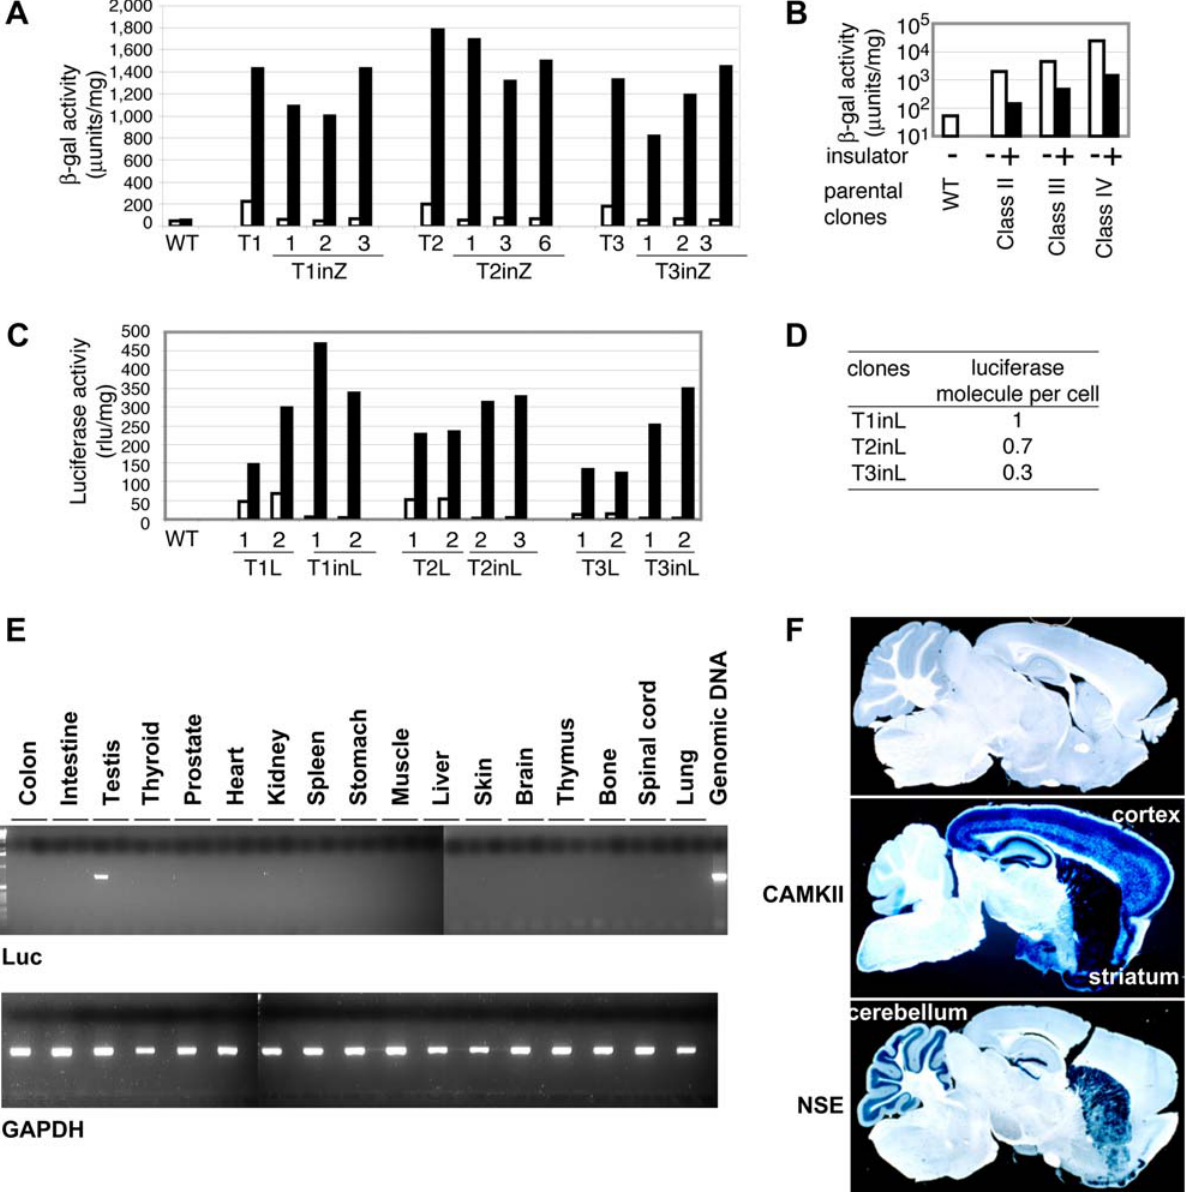
Figure 4. Tightening of gene regulation at TIGRE loci by insulators. (A) Insulator effect in class I clones. Parental ES clones without the insulator (T1, T2, T3) and clones with the insulator (T1inZ, T2inZ, T3inZ) were transfected by tTA expression vector, and b -gal activity was measured 48 hours post-transfection. Three independent integrant clones with insulator were analyzed in each integration site. A luciferase expression vector was cotransfected to normalize the b -gal activities. Clone numbers correspond to those in Figure S1. WT, wild type ES cells. Bars: open, without tTA; filled, with tTA. The same symbol was used in (B) and C). (B) Insulator effect on basal b -gal activity in class II, III and IV clones. Insulator sequence